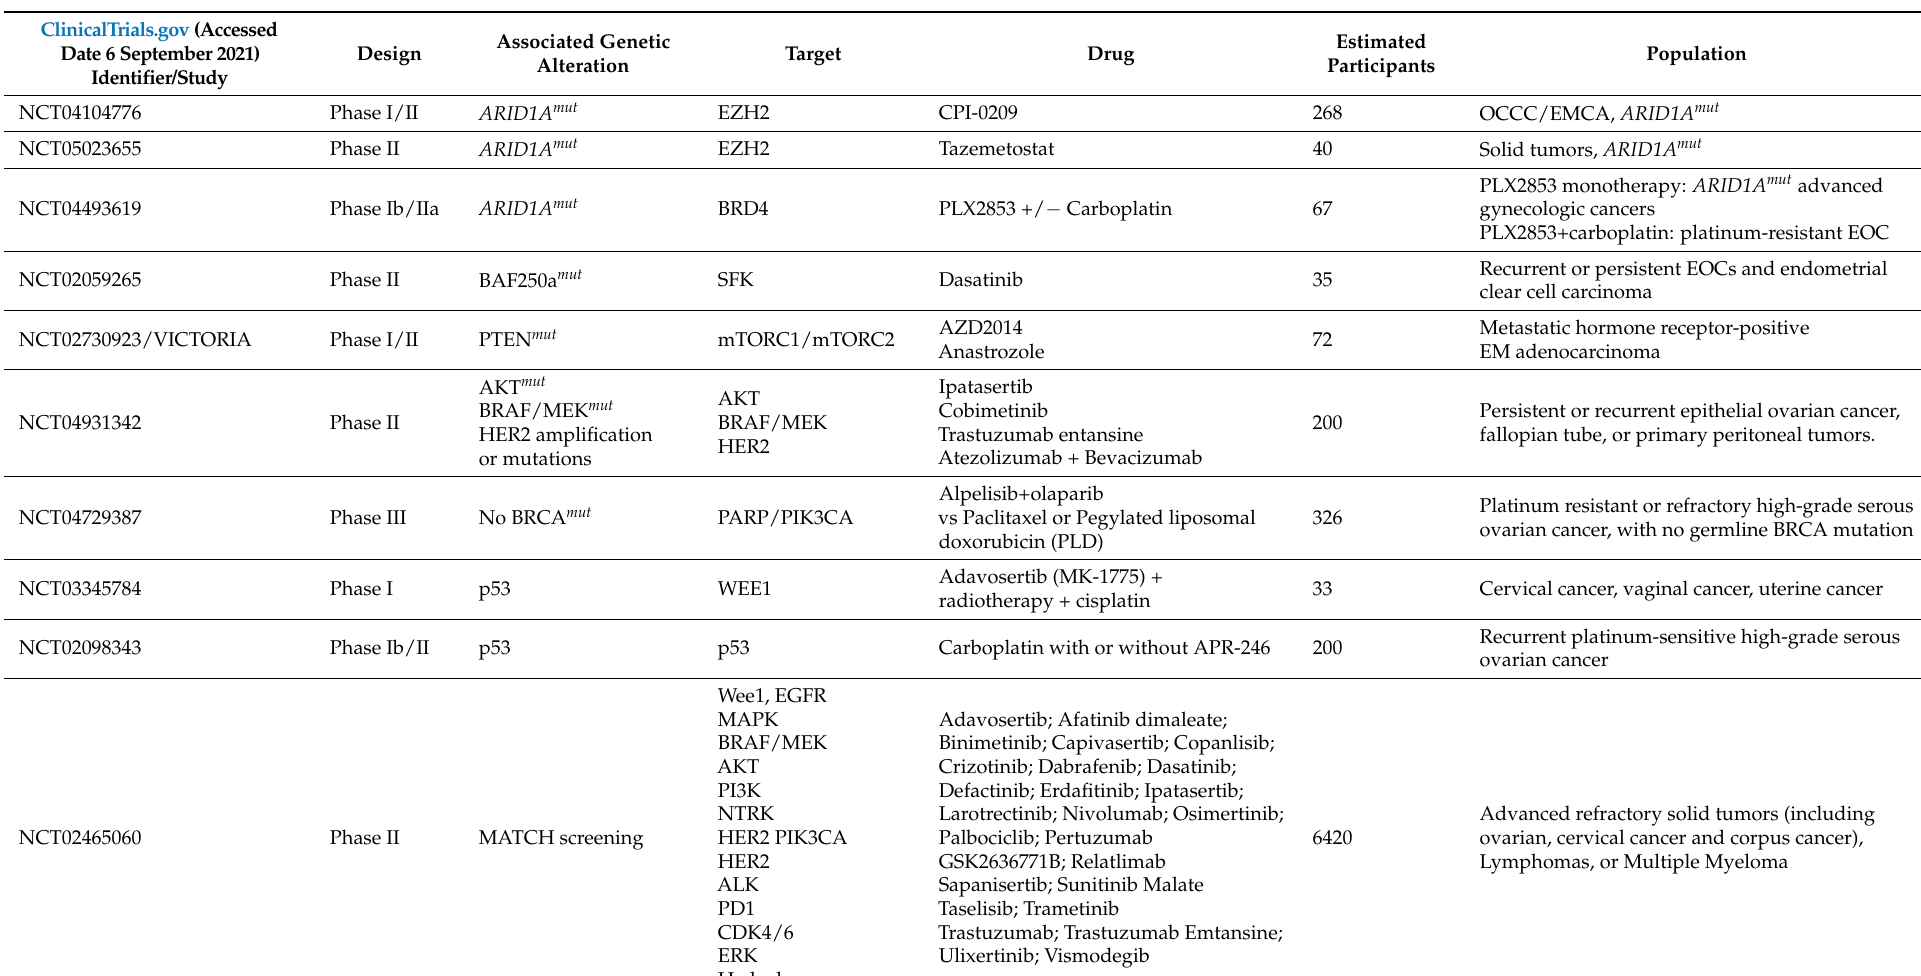
Table 3. Ongoing trials of targeted therapy in ARID1A and other genetic alterations in gynecologic